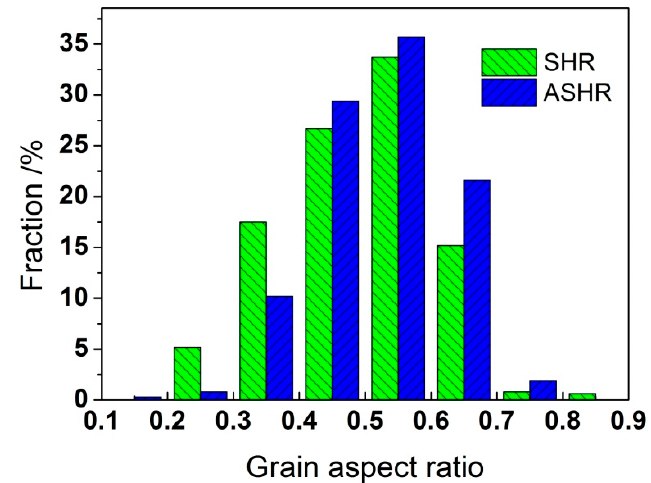
Figure 6. Fraction area of grain with different aspect ratio of recrystallized grains and grain aspect ratio in the SHR and ASHR processes.